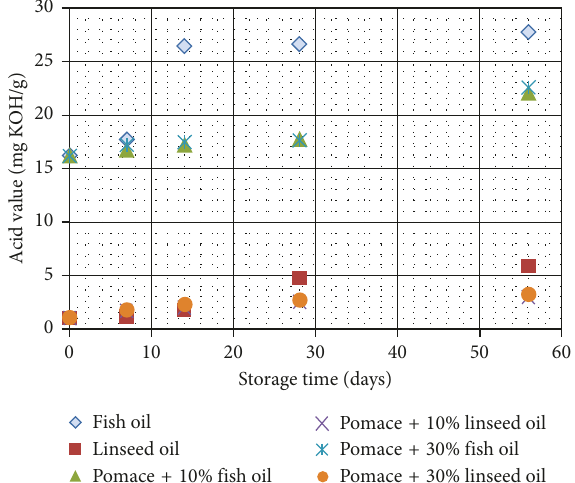
Figure 1: Changes in acid number (mg KOH/g) of the test oils stored with the addition of apple pomace.